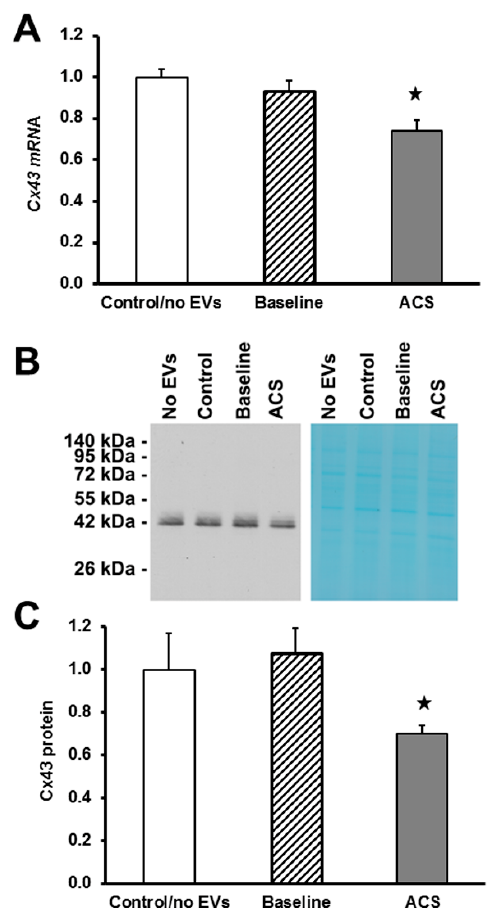
Figure 5. Levels of endothelial Cx43 after treatment with ACS plasma-derived EVs. ( A ) RNA was isolated and Cx43 mRNA levels were quantified by real time RT-qPCR. The graphs show the values normalized to the average values in control/no EVs ( n = 3) treated cells. There was a significant decrease in Cx43 mRNA levels in cells treated with ACS EVs ( n = 8) ( 🟊 , p < 0.05 as compared to baseline EVs treated cells by ANOVA followed by Tukey post-hoc test). ( B ) Representative blot for Cx43 is shown (left panel). MEM Code Reversible Protein Staining of PVDF membrane proves loading of equal amounts of total protein in each lane (right panel). ( C ) Cx43 protein levels were quantified by densitometry. Graphs show the amounts of immunoreactive connexin in each group, normalized to the control/no EVs treated cells. Cx43 protein levels were significantly decreased in cells treated with ACS EVs, compared to cells treated with baseline EVs or control/no EVs ( 🟊 , p < 0.05 ANOVA followed by Tukey post-hoc test).